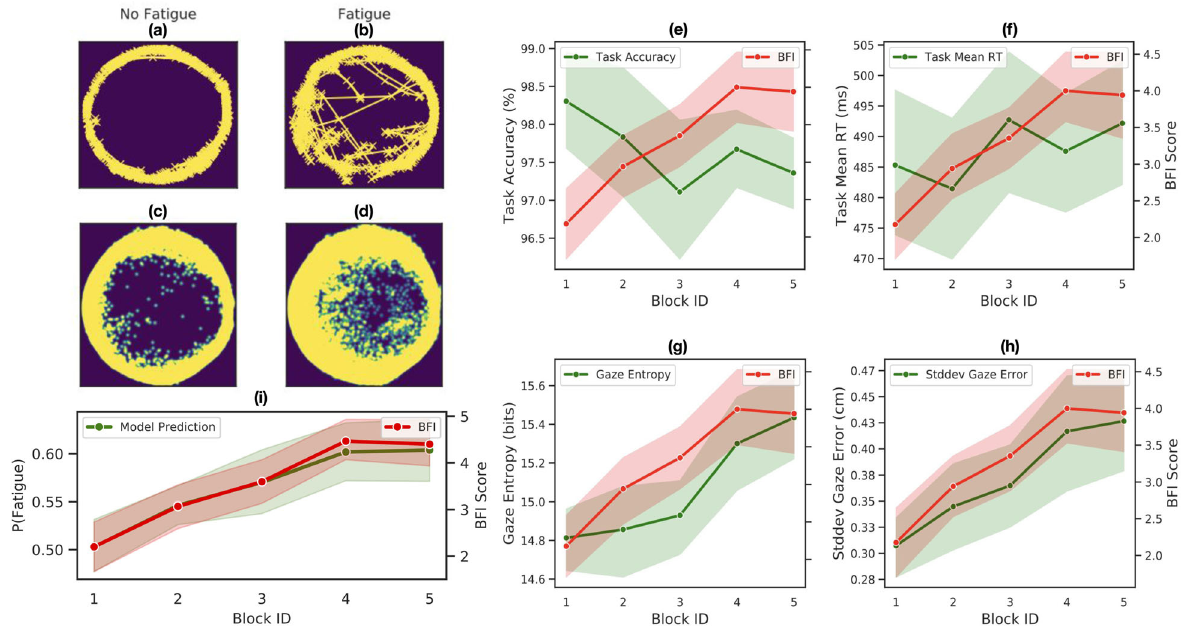
Fig. 2 Progression of fatigue, gaze, and task performance features over time. a , b Sample gaze patterns from a single participant for the "No Fatigue'' vs. "Fatigue'' condition. c , d Corresponding population-level gaze heatmaps. e – h . Progression of task and gaze features over time. Error bands denote the Mean ± SEM ( n = 17 participants). i Model prediction of the probability of fatigue over time, along with the self-reported BFI